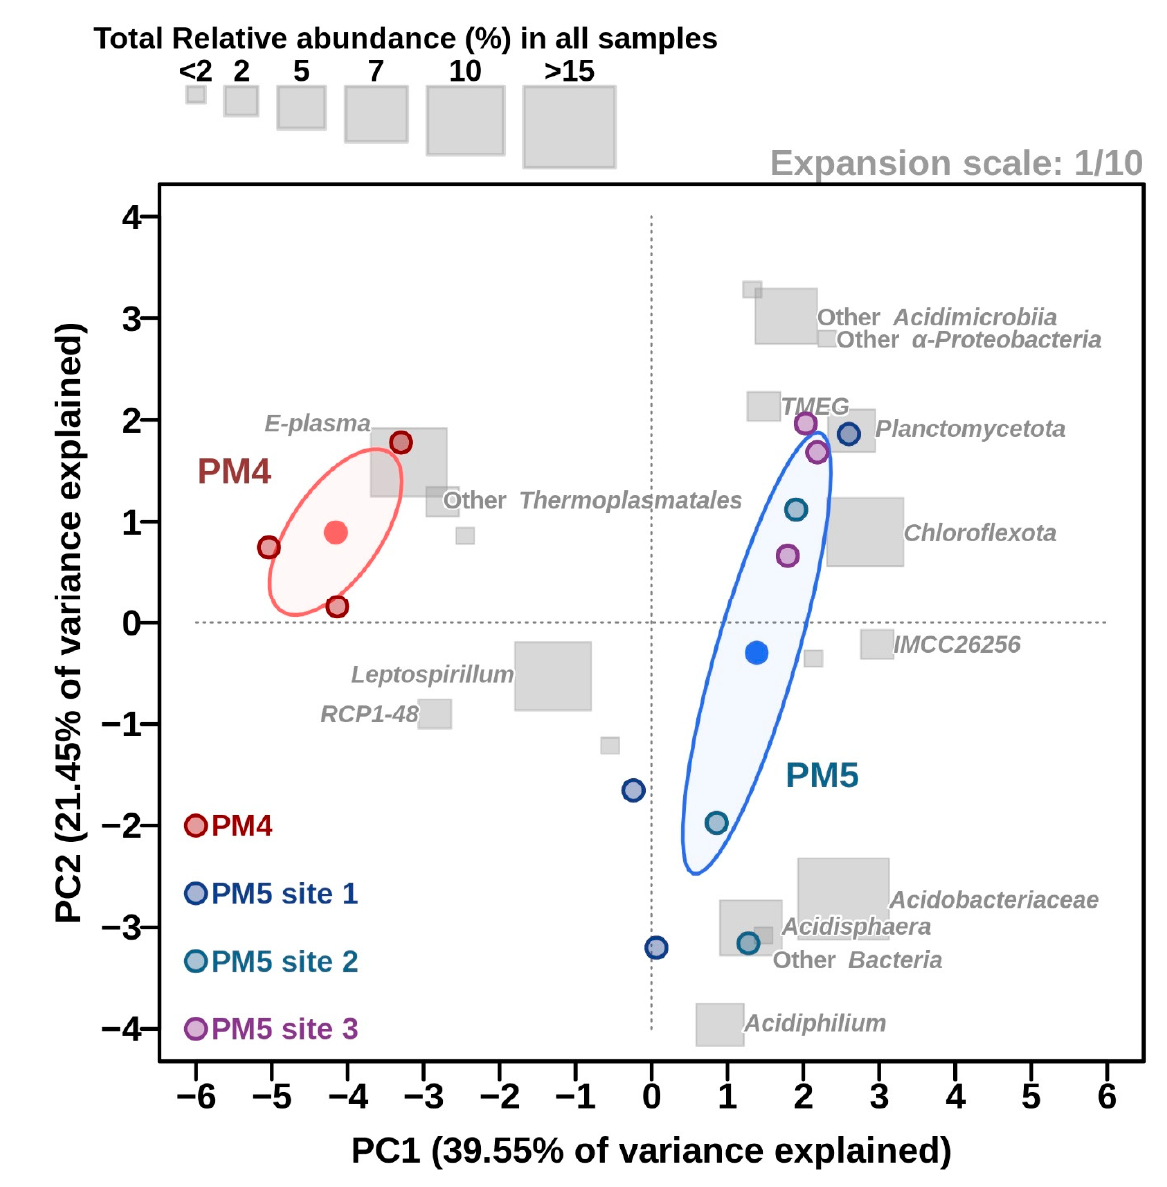
Figure 5. Principal component analysis (PCA) for the relative read numbers of the most-abundant taxonomic groups (MATGs). Any taxon is considered a MATG if it reaches a relative abundance over ≥ 2%; otherwise its relative read counts are added to the immediate upper lineage level. Once all genera were sorted, the upper level of the lineage was analysed in the same way but without considering the corresponding relative abundance already covered in the MATGs. Ellipses were calculated for the two different locations (PM4 in red and PM5 in blue), based on the mean (dots at the ellipse centre) and the variance among the samples. Total relative abundance of each MATG among all samples is shown by the grey rectangles. The expansion scale represents the proportion at which variables’ (MATGs’) axes are drawn regarding the site axes.